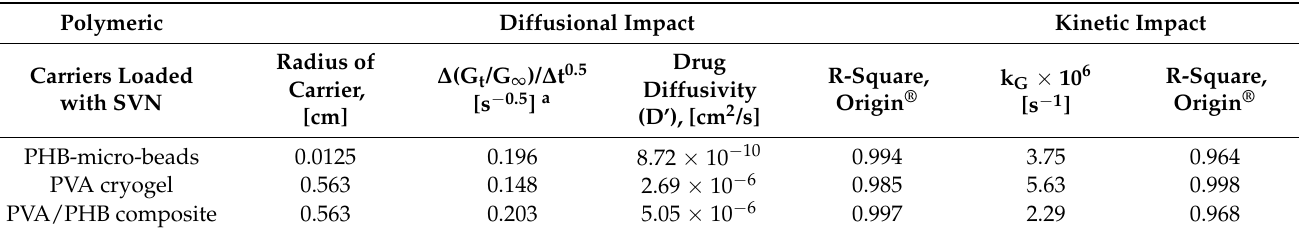
Table 2. Characterization of drug release from the polymer